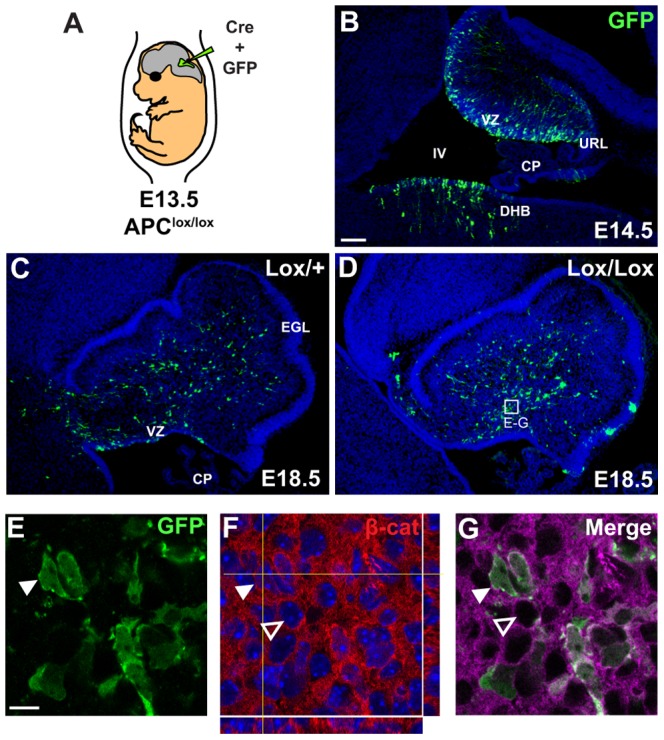
Genetic activation of Wnt/β-catenin signalling in VZ-derived cells by in utero electroporation.(A) Schematic illustration showing in utero electroporation technique. E13.5 Apclox/lox or Apclox/+ embryos were injected in utero with a Cre-GFP plasmid delivered to the fourth ventricle and electroporated. (B) GFP expression in an electroporated embryo at E14.5, revealing extensive expression along the VZ. (C, D) By E18.5 GFP expression was widespread throughout the developing cerebellum of both Apclox/+(C) and Apclox/lox (D) embryos. (E–G) High magnification analysis of GFP+ cells revealed that majority of them also displayed ectopic nuclear accumulation of β-catenin (white arrowheads) compared to non-GFP cells (empty arrowheads). All sections were counterstained with TOPRO3. CP = choroid plexus, DHB = dorsal hindbrain, EGL = external granule layer, IV = fourth ventricle, URL = upper rhombic lip, VZ = ventricular zone. Scale bar = 100 µm (A–C), 10 µm (D–F).